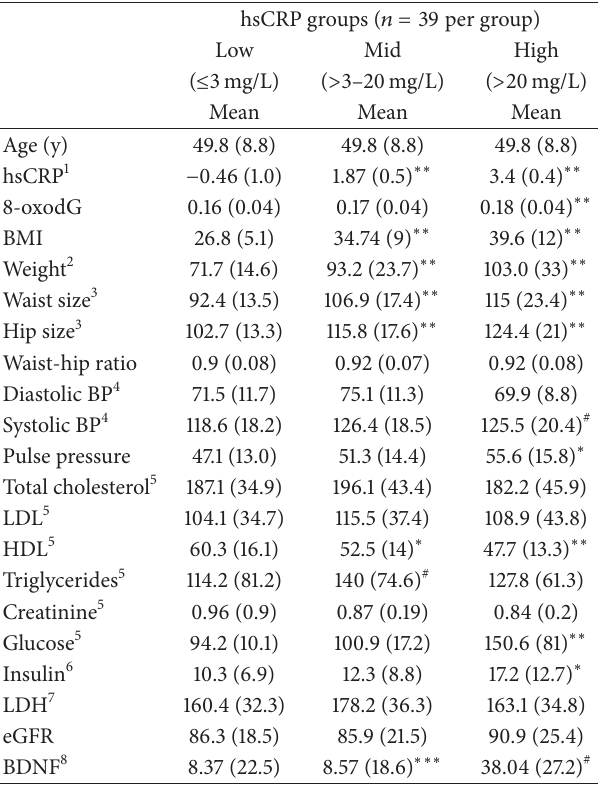
Table1:Clinicalcharacteristicsofcohortwithseparatecomparisons between middle and high hsCRP groups with the low hsCRP